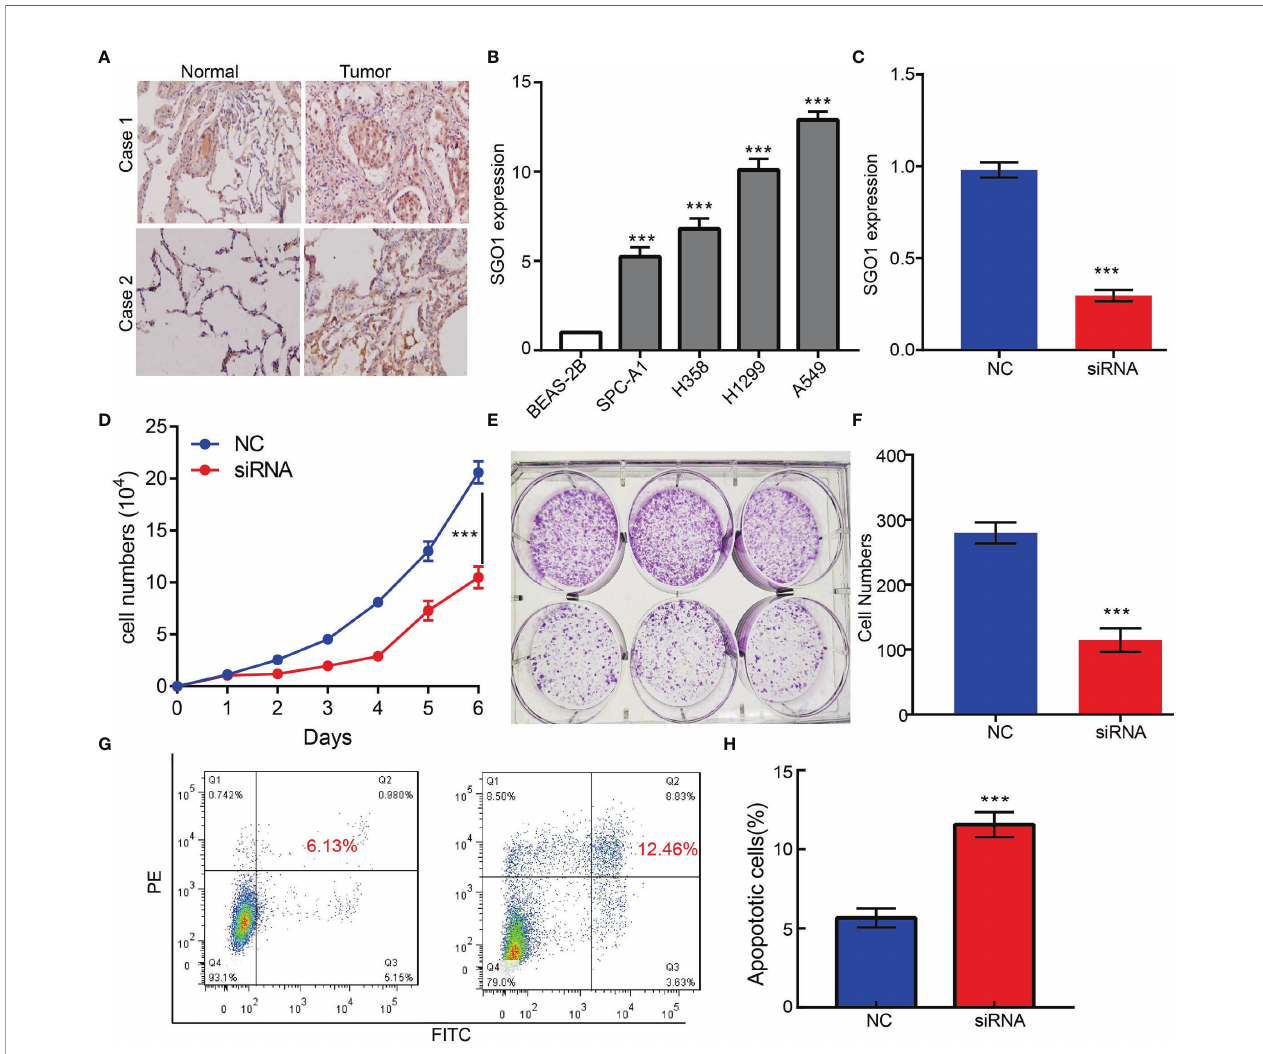
FIGURE 11 | SGO1 modulates LUAD cell proliferation and migration in vitro . (A) The relative expression level of SGO1 in lung adenocarcinoma cancerous tissues examine by IHC assay. (B) The relative expression level of SGO1 in lung adenocarcinoma cancerous cell lines, including SPC-A1, H358, H1299, and A549 examined by real-time RT-PCR, compared to normal human bronchial epithelial cell line: BEAS-2B. (C) Establishment of SGO1 knockdown cell lines in A549 veri fi ed by real- time RT-PCR. (D – F) Knockdown of SGO1 signi fi cantly inhibits cell proliferation determined by CCK8 and colony formation assay. (G,H) Knockdown of SGO1 dramatically promotes cell apoptosis. ***P < 0.001. NC = negative control, siRNA = SGO1 siRNA. ***P <